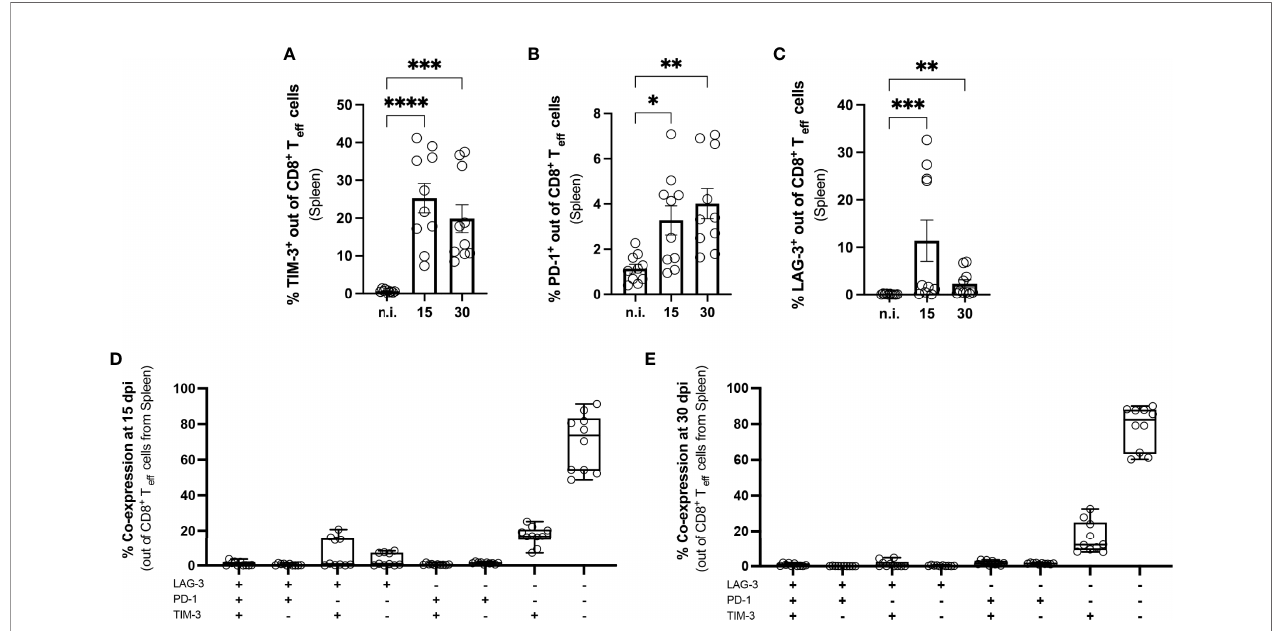
FIGURE 3 | Induction of co-inhibitory receptors on splenic CD8 + T cells from mice with acute T. cruzi infection. Flow cytometric analysis of splenic CD8 + T cells at 15 and 30 dpi. The gating strategy is depicted in S. 1 (A) Effector CD8 + T cells were de fi ned as CD44 + CD62L - . Results are presented as percentages of effector CD8 + T cells (A) for TIM-3, (B) for PD-1 and (C) for LAG-3. A boolean gating analysis was performed to combine these three markers (D) for 15 dpi and (E) for 30 dpi. Data are from three independent experiments. Data in (A – C) were compared using the Kruskal-Wallis test and Dunn ı ́ s multiple comparison test. Results are presented as mean ± SEM (n.i. n = 10; infected day 15 n = 10; day 30 n = 10). *p < 0.05, ** p < 0.01, ***p < 0.001, ****p < 0.0001.